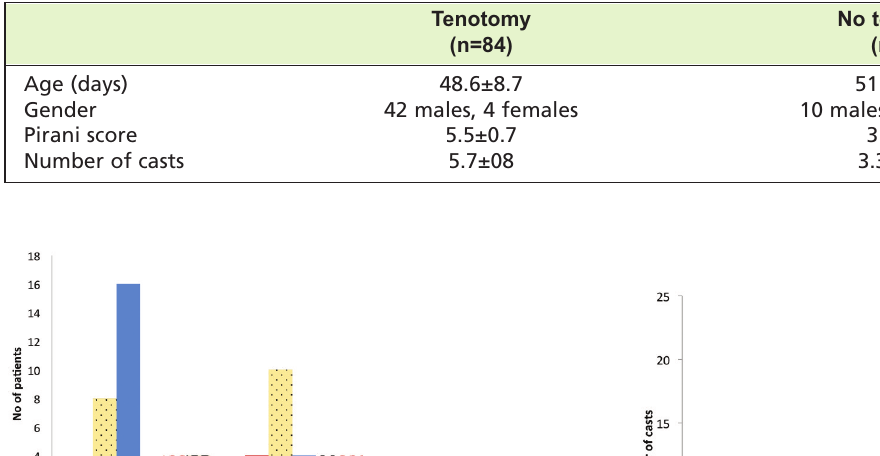
Summary of patient demographics and treatment outcome between the two Table II: